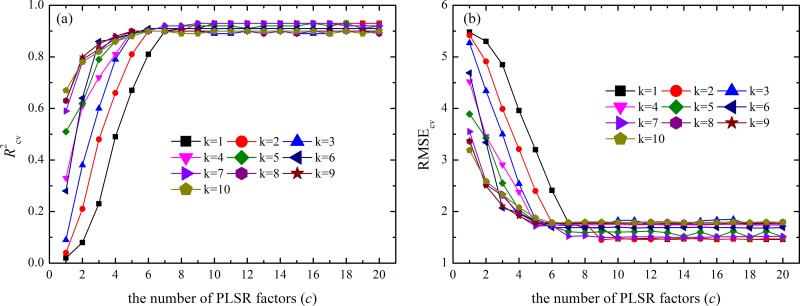
(a) R
2
cv and (b) RMSEcv values of SSCs in dataset B using the corrected spectra with different numbers for the EPO dimension (k, denoted in the legend) and PLSR factor (c, denoted on the x- axis).